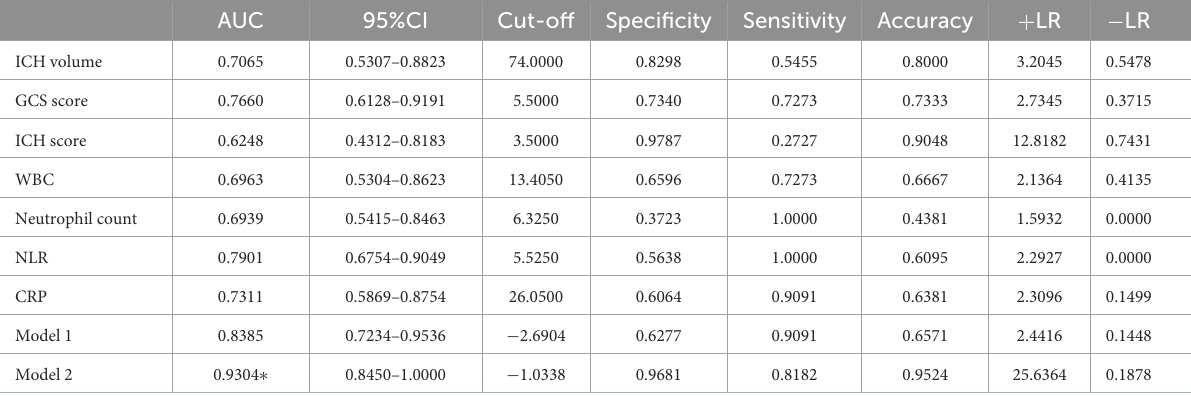
TABLE 4 Comparisons of risk factors of ICH